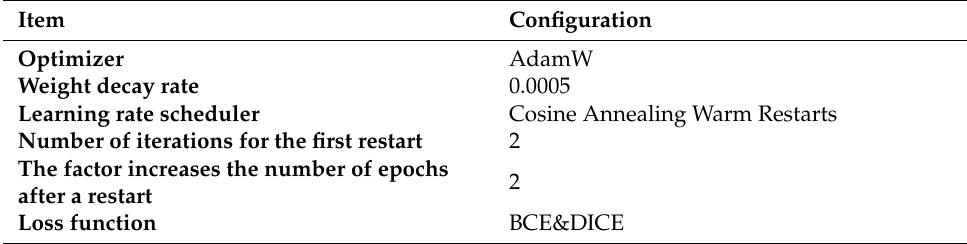
Table 1. Experiment